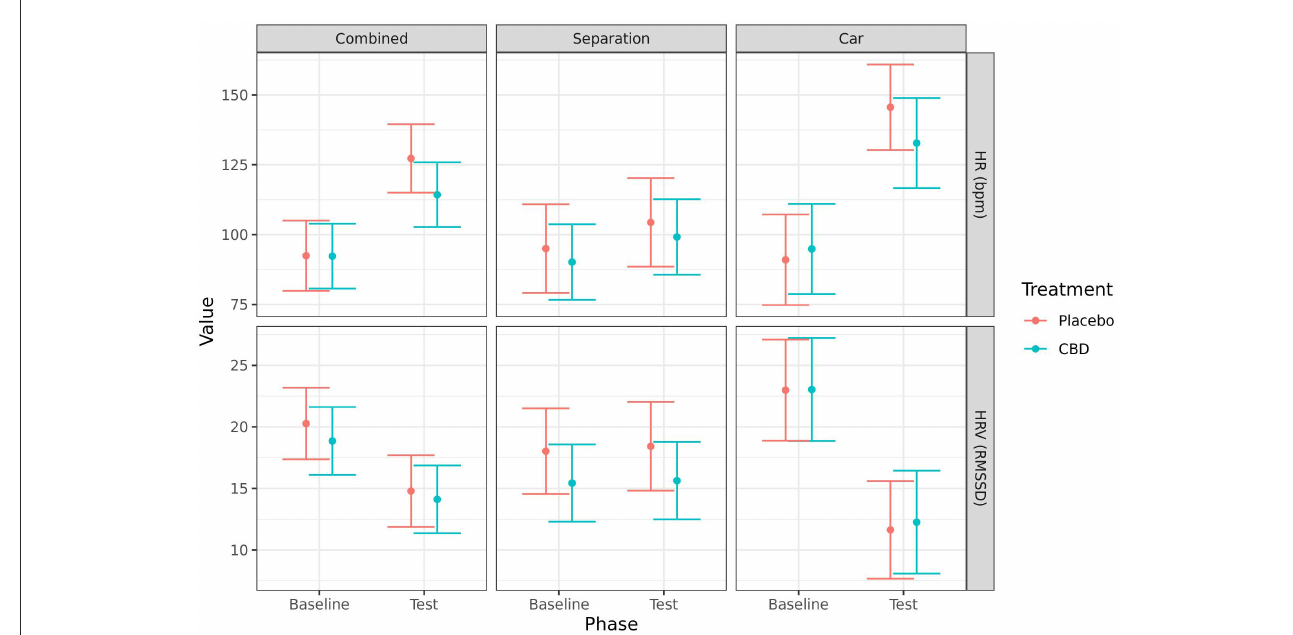
FIGURE5 Predicted mean (95% CI) heart rate (beats/min) and HRV (RMSSD) for dogs given CBD or placebo at each phase of testing (baseline and test) based on models analyzing both stress tests combined, separation test or car test. No significant differences (p < 0.05) were identified between treatment groups within each